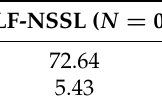
Table 1. The testing accuracy γ and the standard deviation (std.) on the MNIST dataset using k -means, spectral clustering, and RLF-NSSL ( N = 0, i.e., no labeled samples). We use the way proposed in [73] to determine the labels of the clusters in the case of unsupervised learning. For the k -means, we use the randomly initialized clustering center and take 270 iteration steps. The similarity is characterized by Euclidean distance. For spectral clustering, we use the SpectralClustering function from the “sklearn” package in